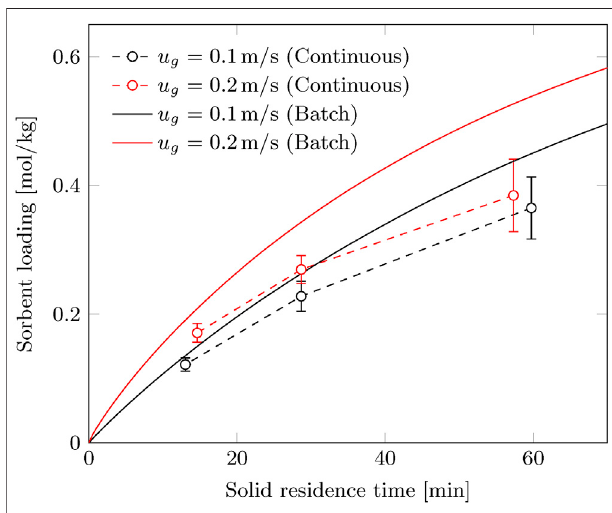
FIGURE 7 | Working capacity of the continuous process compared to the batch process at corresponding solid residence time.